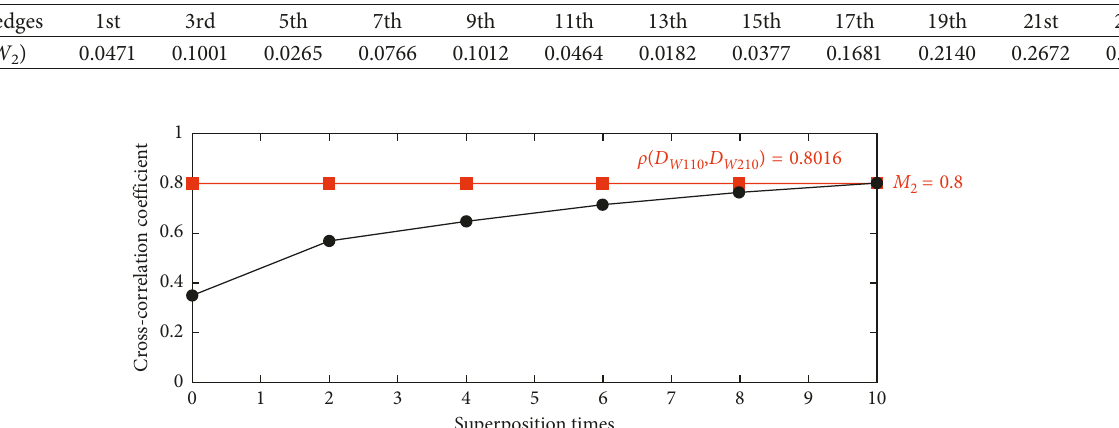
Figure 19: Abnormal noise signal of connecting rod bearing knocking and pulse signal under 1100 r/min speed. Table 4: ρ ( W 1 , W 2 ) calculated from the first to the ninth rising edges.